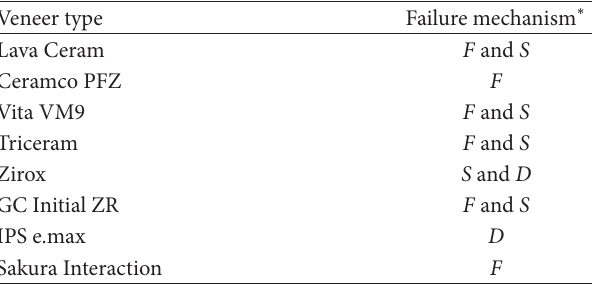
Table 3: Failure mechanism of two-layered zirconia-veneer speci- mens.